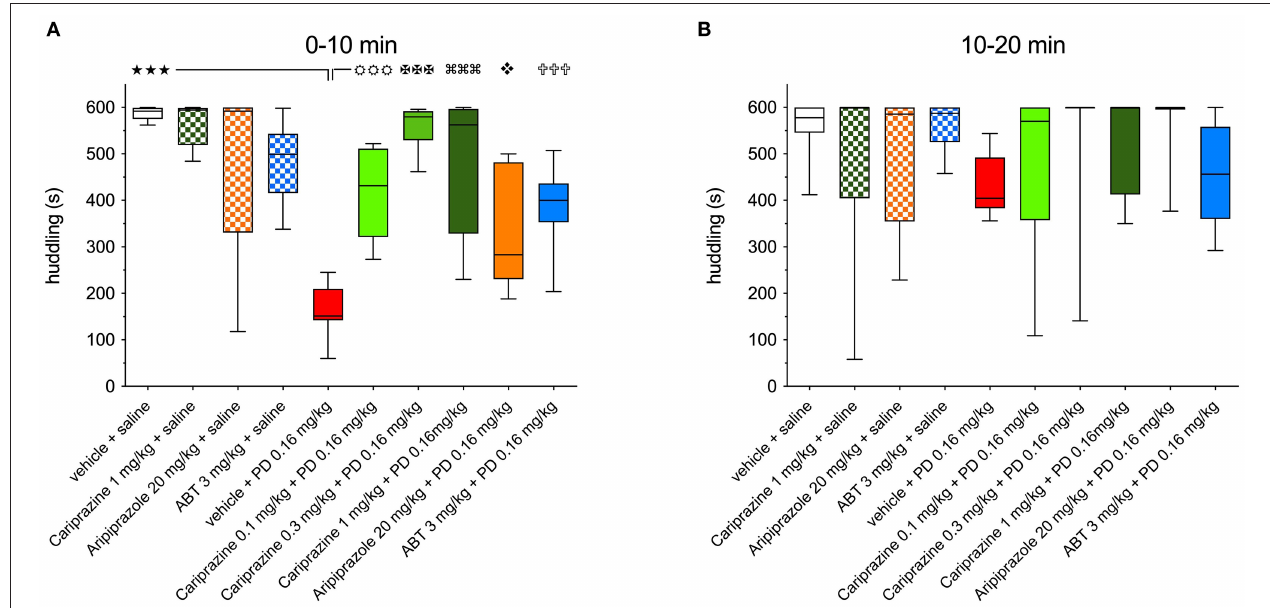
FIGURE 3 | The effects of cariprazine, aripiprazole and ABT-925 on the ( + )-PD 128907-induced disrupted huddling during (A) the first 0-10-minute period and (B) the second 10–20min period post-treatment; mean ± SEM, n = 8; ( ) P < 0.001; ( ) P < 0.001, ( ) P < 0.001, ( ) P < 0.001 ( ) P < 0.05, ( ) P < 0.001, one-way ANOVA followed by Šidak’s multiple comparison test.